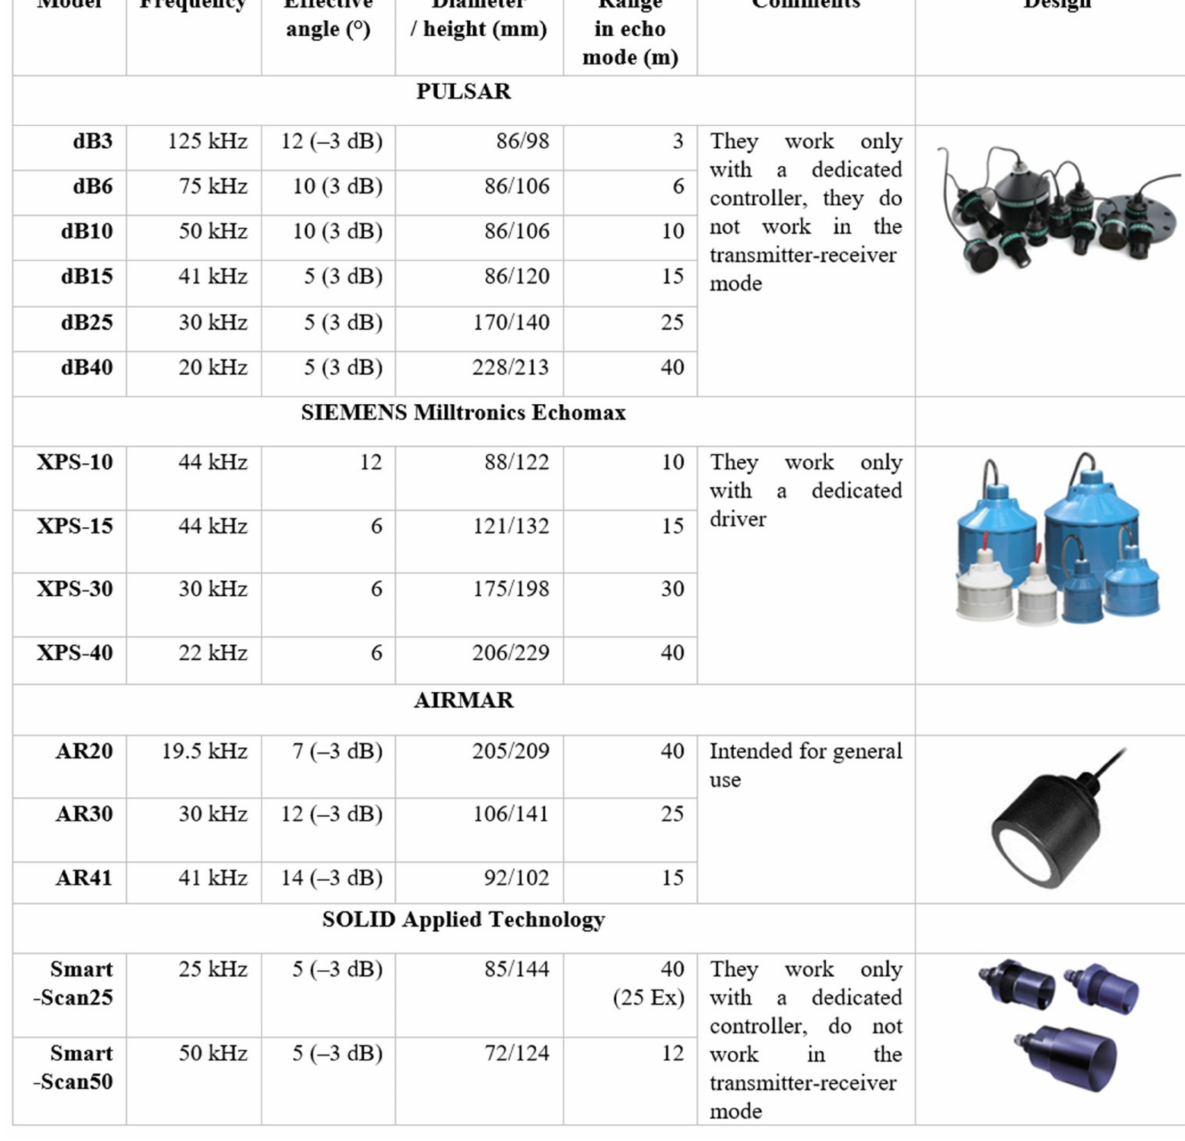
Figure 7. Parameters of ultrasonic transducers available on the